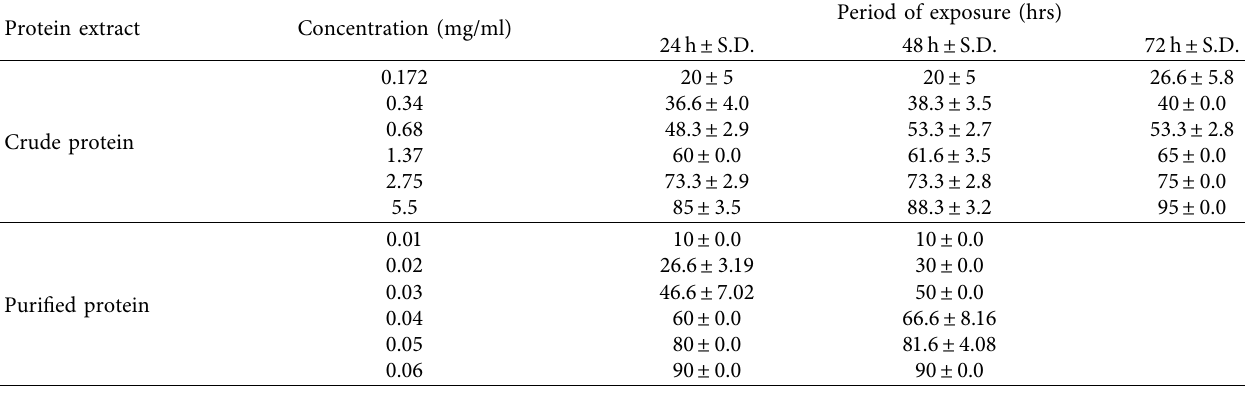
Table 2: Percentage mortality of 3 rd instar larvae of An. stephensi at diferent concentrations of dialyzed crude and purifed protein extract. Protein extract